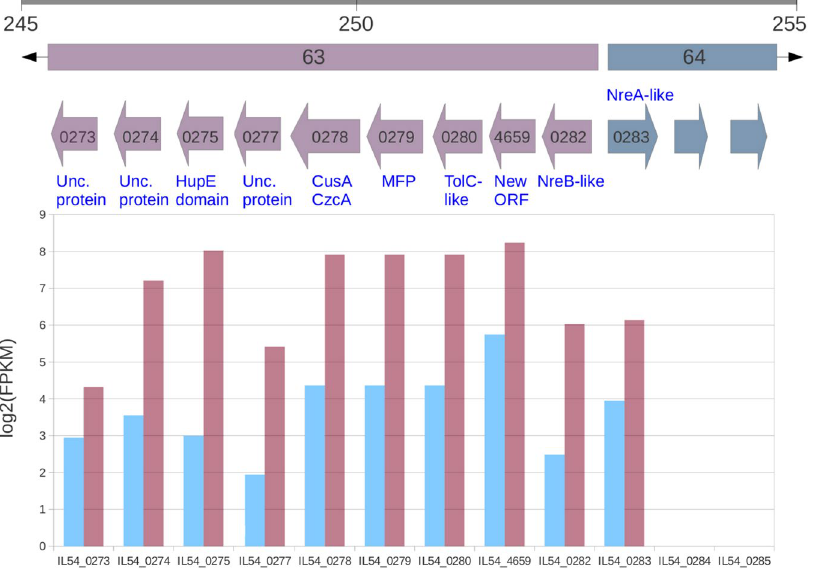
Figure 2. Arrangement and differential expression of genes in the cluster associated with EuGene putative operon n. 63. Gray bar indicates the relative position (in Kb) of the differentially expressed cluster in the JPPQ01000083 contig. Putative operons are indicated by colored bars with black arrow heads. Colored arrows represent genes (identified by the numeric part of their accession number). The name of the encoded protein is given above or under the genes, according to their orientation. The lower panel shows log expression level (FPKM) of genes under control (blue) and LB-Ni (purple) culture